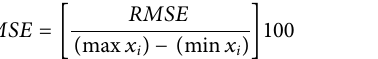
where SS res is the sum of squares of residuals, SS tot is the total sum of squares, x i is the in situ data for a given parameter, y i is the estimated value for a given parameter and N is the sample size.